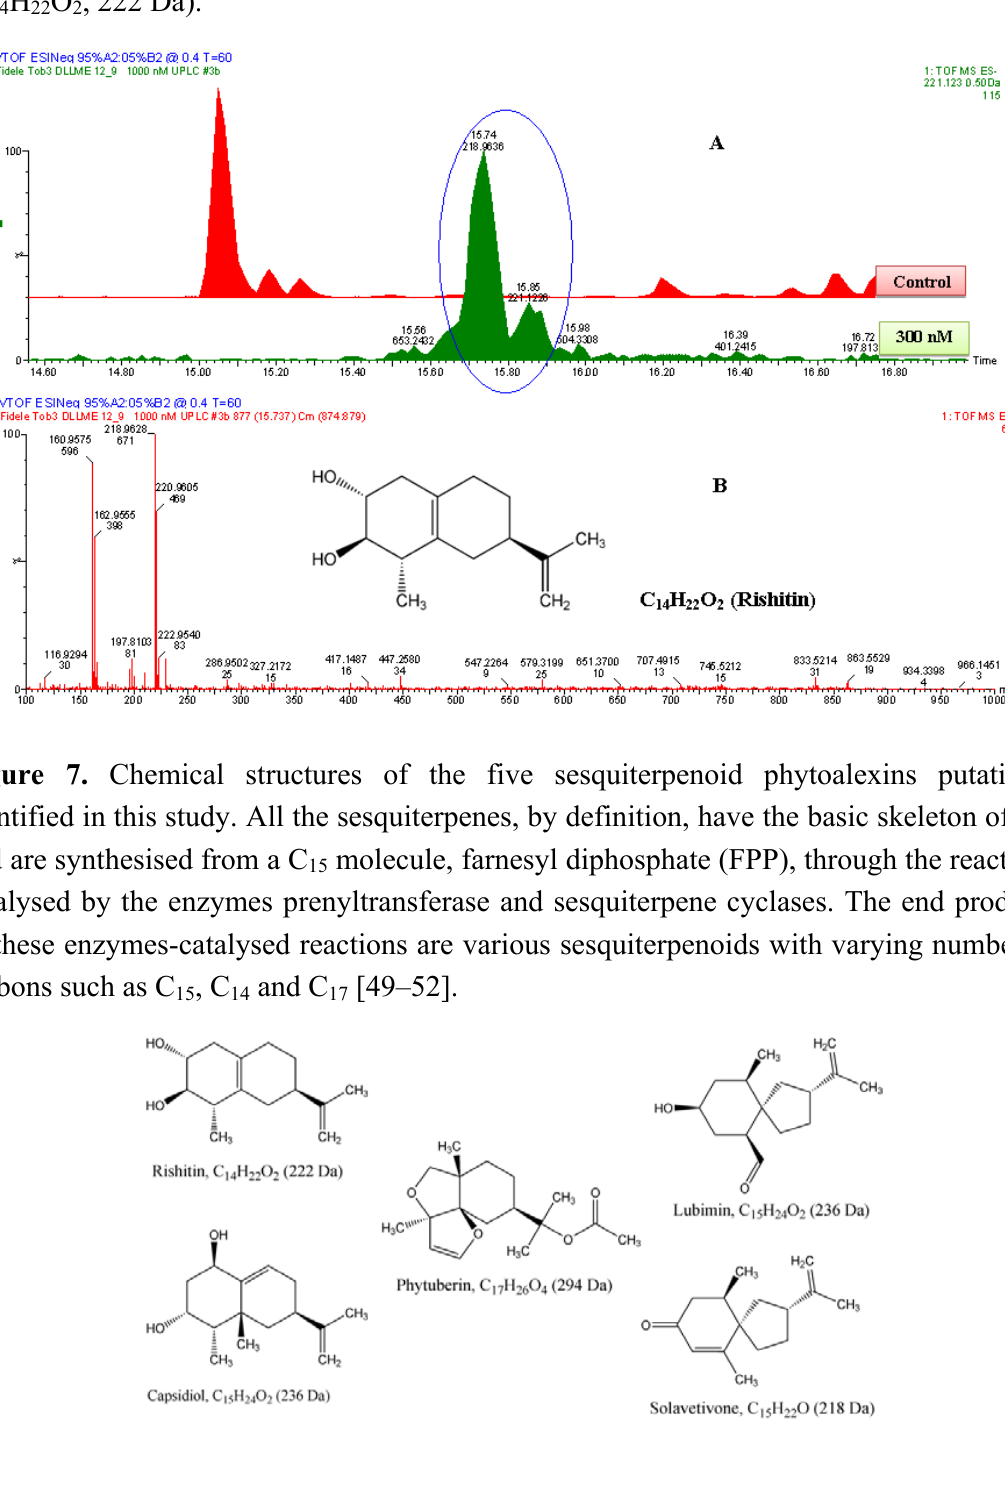
Figure 6. The identification of rishitin. ( A ) The zoomed-in extracted ESI − -MS TICs comparing non-treated (control) and 1000 nM-treated samples. The encircled ion peak is present only in the treated sample. ( B ) An ESI − -MS-spectrum of the ion peak of 221.122 Da that eluted at 15.85 min. Based on the spectrum of the ion, the empirical formula calculated (and selected) was C H O , with i-FIT of 1.1 and DBE of 4.5. Since the ion was 14 21 2 generated by ESI − mode, the calculated empirical formula had one proton (H + ) less. Thus, the corrected empirical formula is C H O ; and searching in databases (with 14 22 2 structural correlation to MS spectrum), the compound was putatively identified as rishitin (C H O , 222 Da). 14 22 2